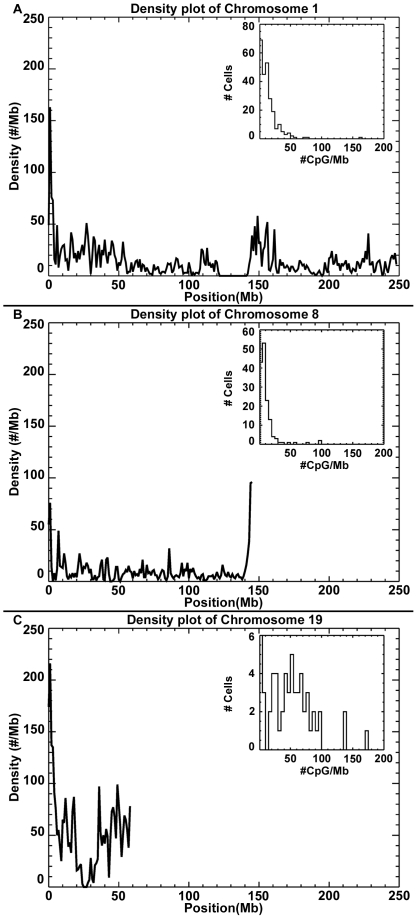
Density plots for chromosomes 1, 8 and 19.Densities are defined as the number of CGI per 1 Mb window. Note the especially high density at the 5′ telomere and the missing sequence at position ∼130 Mb. Inset shows the distribution of densities in the 249 1 Mb windows that comprise the chromosome. The distribution is skewed and demonstrates that simple estimators of the centroid and dispersion are insufficient. Plots for all chromosomes are given in Text S1.